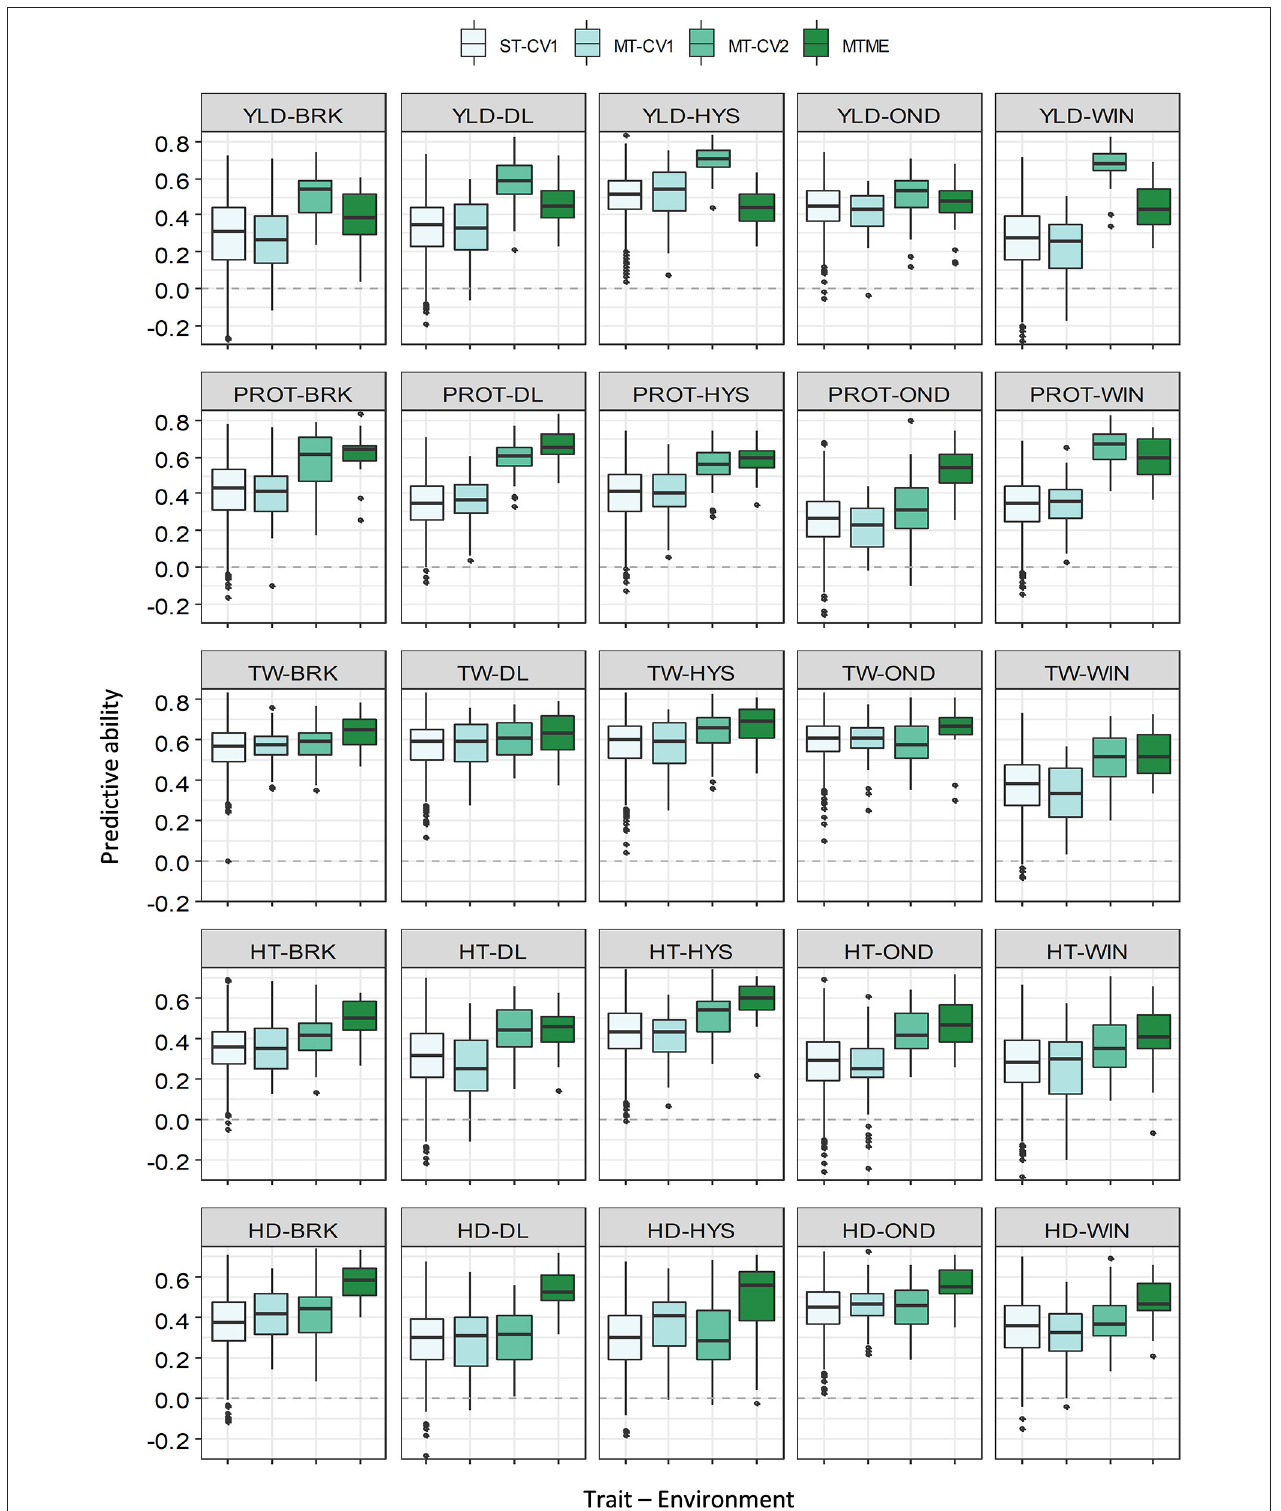
FIGURE 4 | Prediction accuracy (PA) for five agronomic traits evaluated in five environments in the growing season of 2019–20. Boxplots compare the PA using a single-trait prediction model with one cross-validation scheme (ST-CV1), a multi-trait prediction model with two cross-validation schemes (MT-CV1 and MT-CV2), and a Bayesian multi-trait multi-environment prediction model (MTME). Traits include YLD, grain yield; PROT, grain protein content; TW, test weight; HT, plant height; and HD, days to heading.